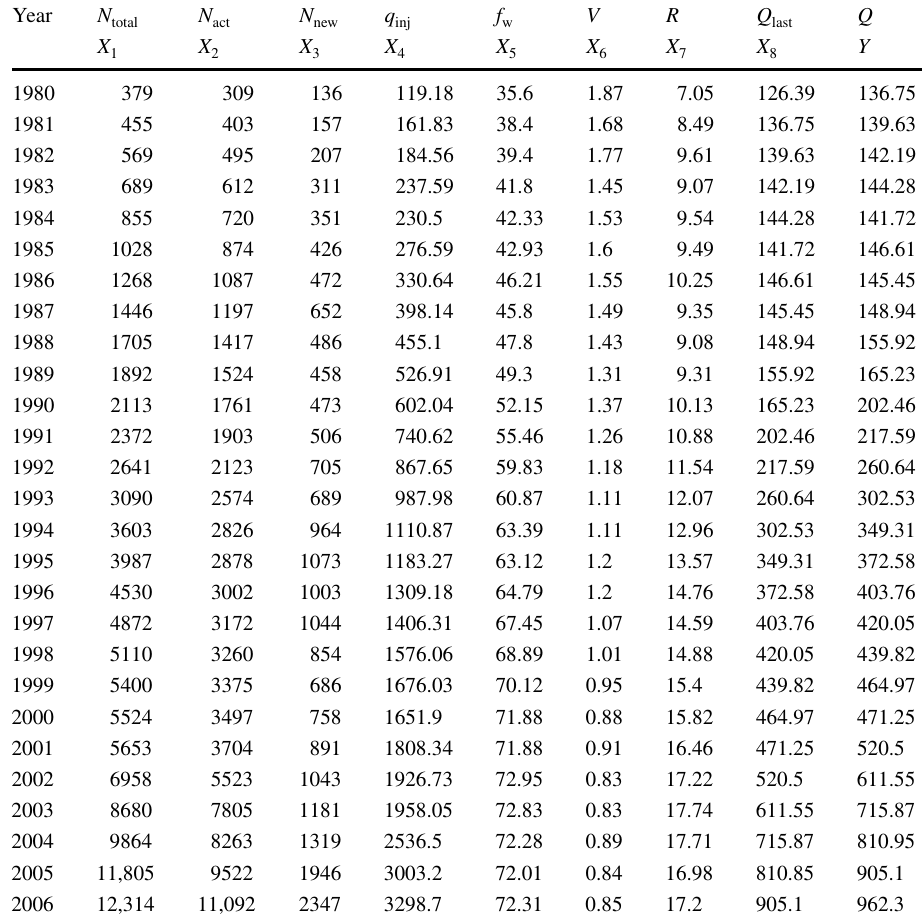
Table 1 Original data sets of parameters for production forecasting of oilfield